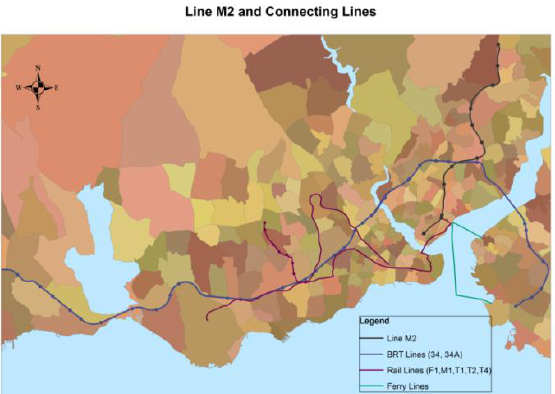
Fig. 5. Multimodal network of line M2 and the specified connecting lines.